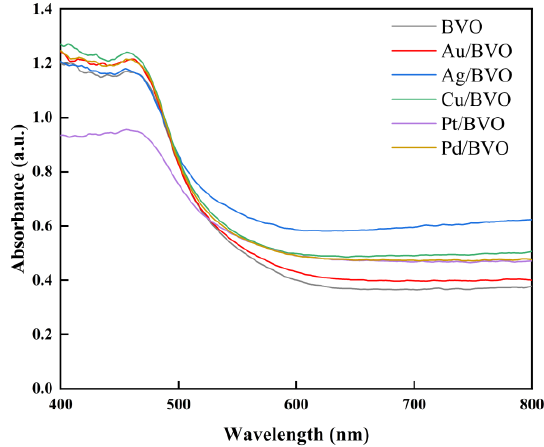
Figure 3. UV-Vis absorption spectra.